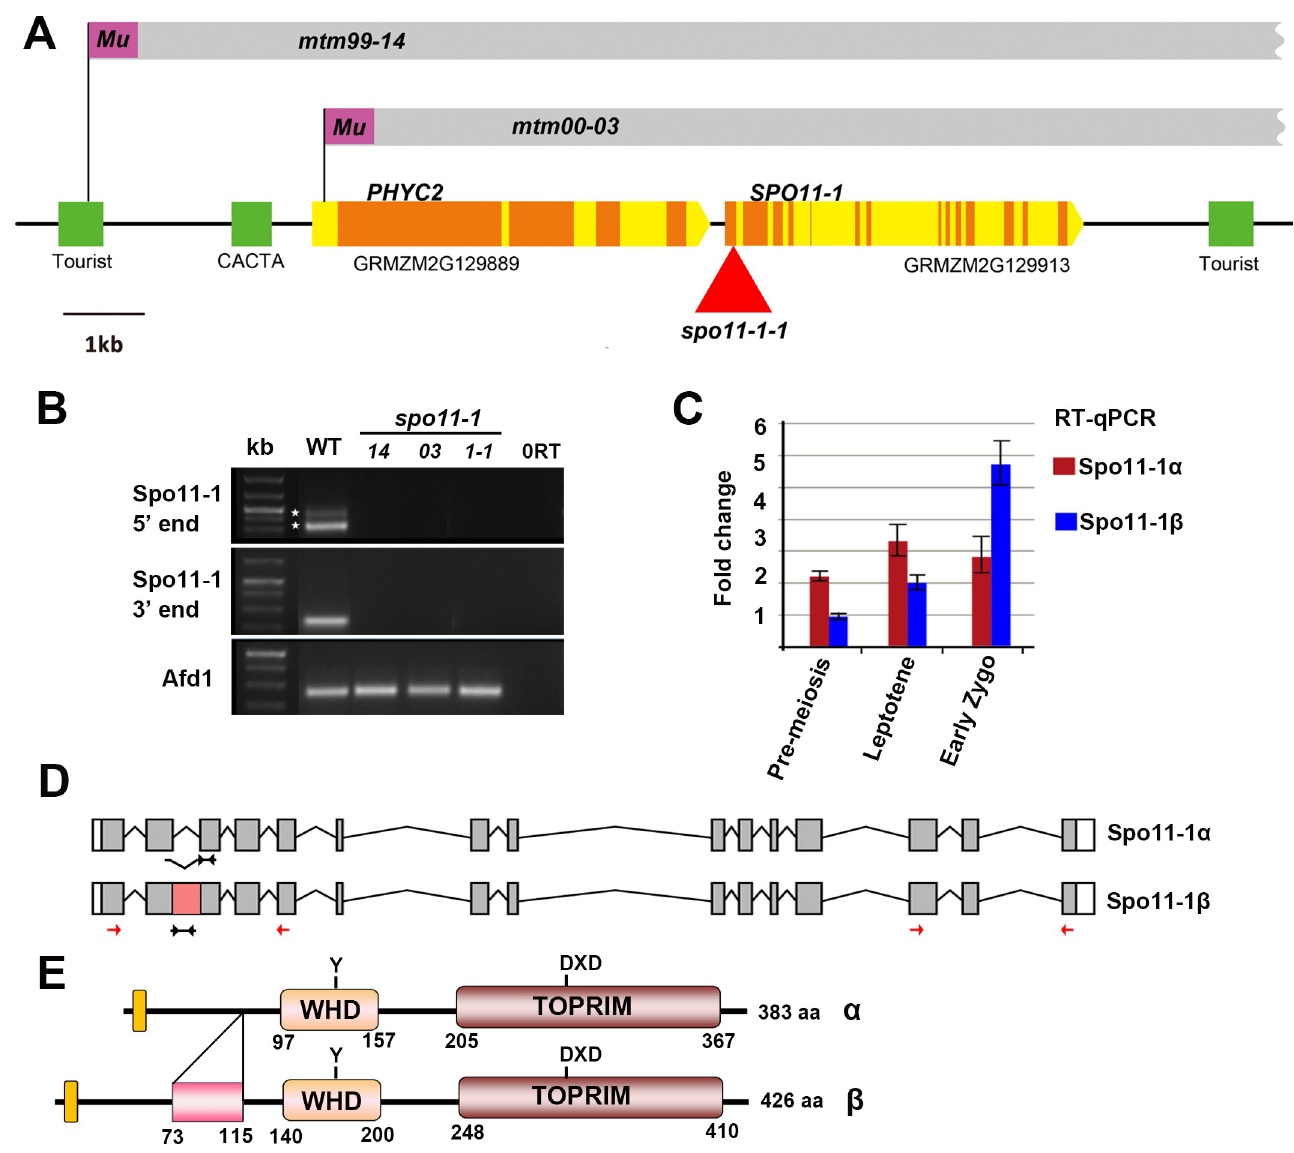
Fig 2. Structure and expression of the SPO11-1 gene. (A) Schematic diagram of the maize genomic region. Both mtm99-14 and mtm00-03 mutants contain remnants of Mu sequences (purple boxes) that are associated with deletions (grey boxes) spanning PhyC2 and Spo11-1 genes. Coding regions and introns/UTRs are represented as orange and yellow boxes, respectively. The additional Mu insertion allele ( spo11-1-1 ) is indicated by a red triangle. Green boxes represent transposable elements (Tourist and CACTA-like elements). (B) RT-PCR analyses to amplify the Spo11-1 at 5’ and 3’ regions exhibited splicing variants (asterisks) in WT and confirmed that Spo11-1 transcripts are absent in all mutant alleles. Positions of primer sets are indicated by red arrows in (D). Afd1/Rec8 expression was used as a control. 0RT represents a negative control lacking cDNA. (C) Quantitative PCR showed differential expression of the Spo11-1 α and Spo11-1 β transcripts using specific primers indicated by black arrows in (D). (D, E) Gene models (D) and predicted proteins (E) of SPO11-1 α and SPO11-1 β are shown. The additional region of SPO11-1 β (amino acid 73–115) is indicated by a pink box. functional SPO11-1 proteins because they contain a nuclear localization signal (KLRR), the topoisomerase-primase ‘TOPRIM’ domain that is essential for catalytic activity, and the con- served tyrosine residue in the winged-helix DNA-binding (WHD) domain (Fig 2E). The larger protein isoform (named Spo11-1 β ) contains an extra 43 amino-acid domain, which is pre- dicted to form an alpha-helix motif upstream of the TopVIA type endonuclease domain (S4